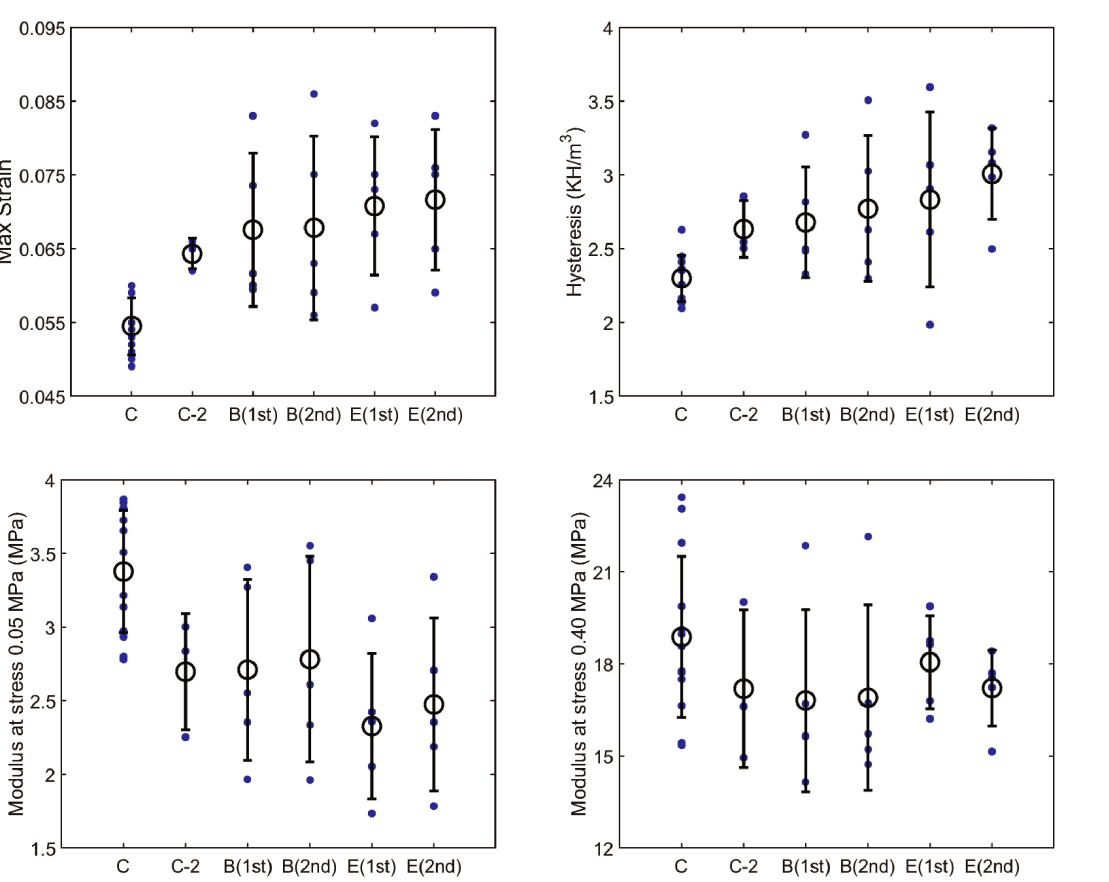
Fig 2. The comparison of mechanical measures that were used to characterize the viscoelastic tensile response of posterior sclera. The measured properties for samples tested immediately after dissection were represented by symbol C and for samples subjected to a second mechanical tested after being tested once and then soaked in buffer for 6 hours by symbol C-2. The measured properties after 6-hour buffer incubation were denoted as B(1st) and E(1st) for strips in the buffer- and enzyme-treated groups, respectively. B(2nd) and E(2nd) represent mechanical properties of the same samples after being incubated for additional 18 hours in buffer and enzyme solution, respectively. The filled circles are the individual data points, the unfilled circles represent the mean values, and error bars denotes one standard